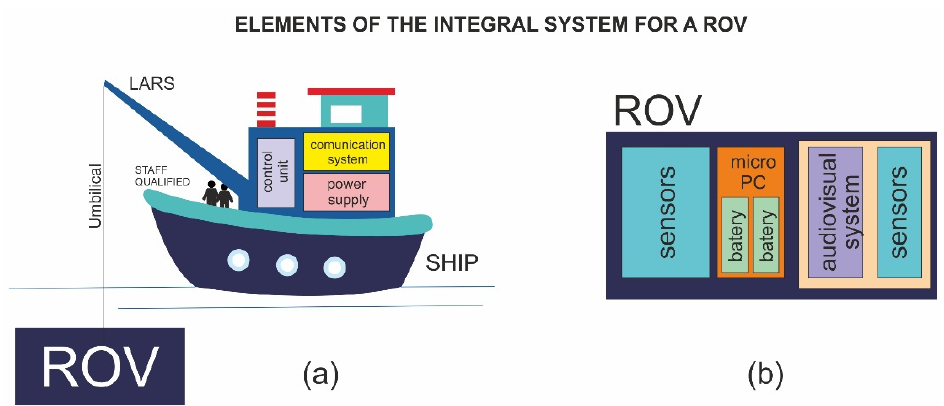
Figure 1. ( a ) Graphic representation of an ROV system. ( b ) Main subsystems of an ROV. Based on [12,13]. on